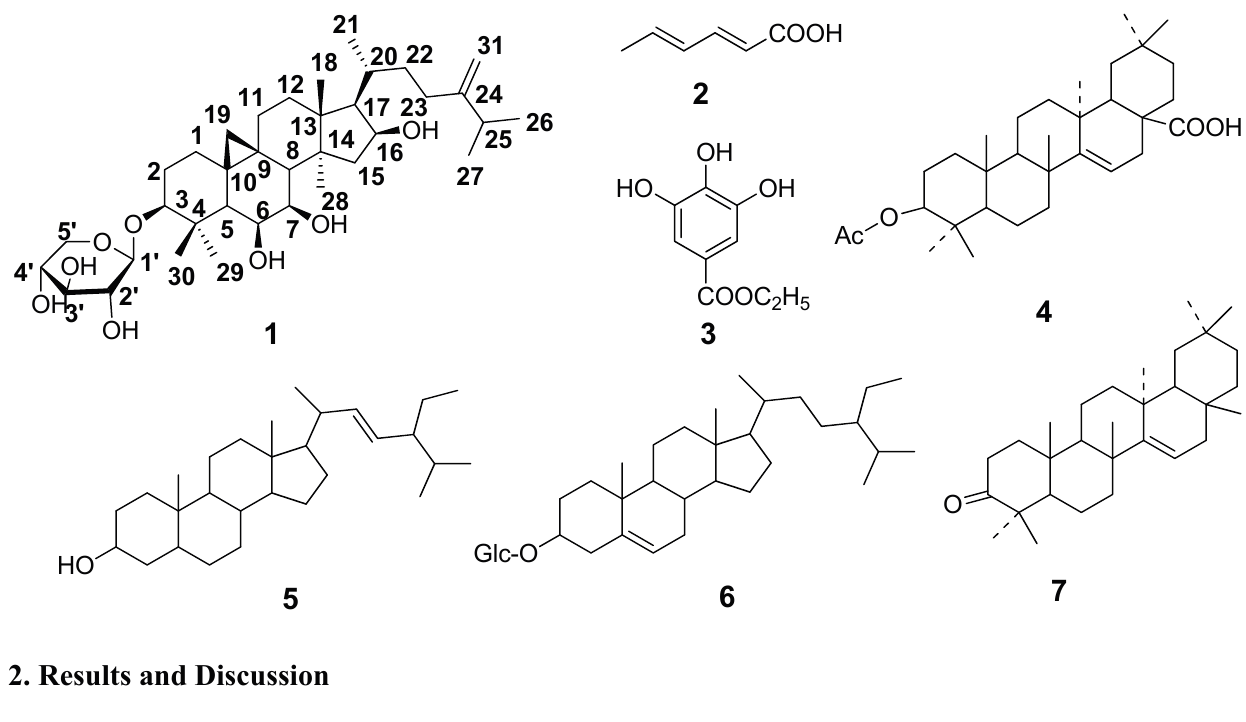
Figure 1. Structure of the compounds isolated from H. riparia